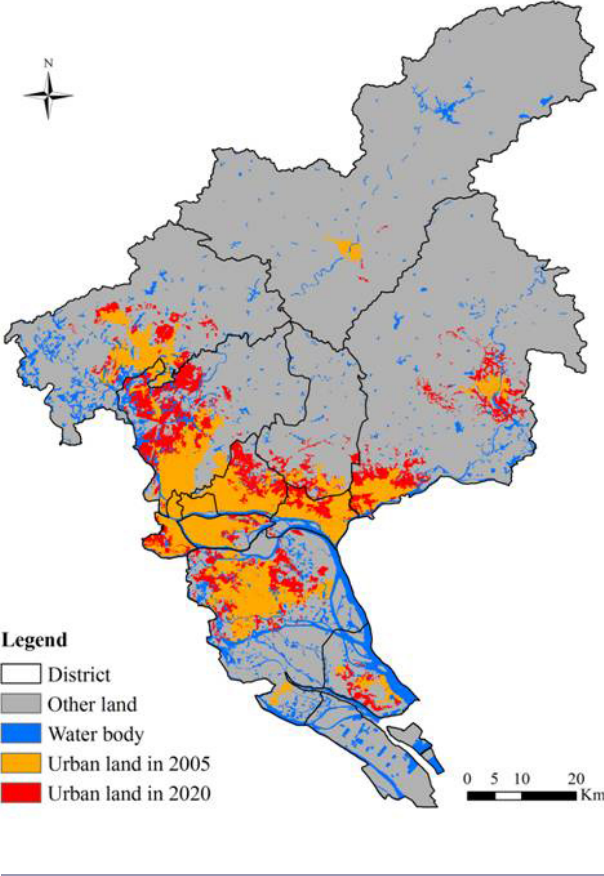
Fig. 6 . The simulation of Guangzhou metropolitan region in 2020 for green land protection